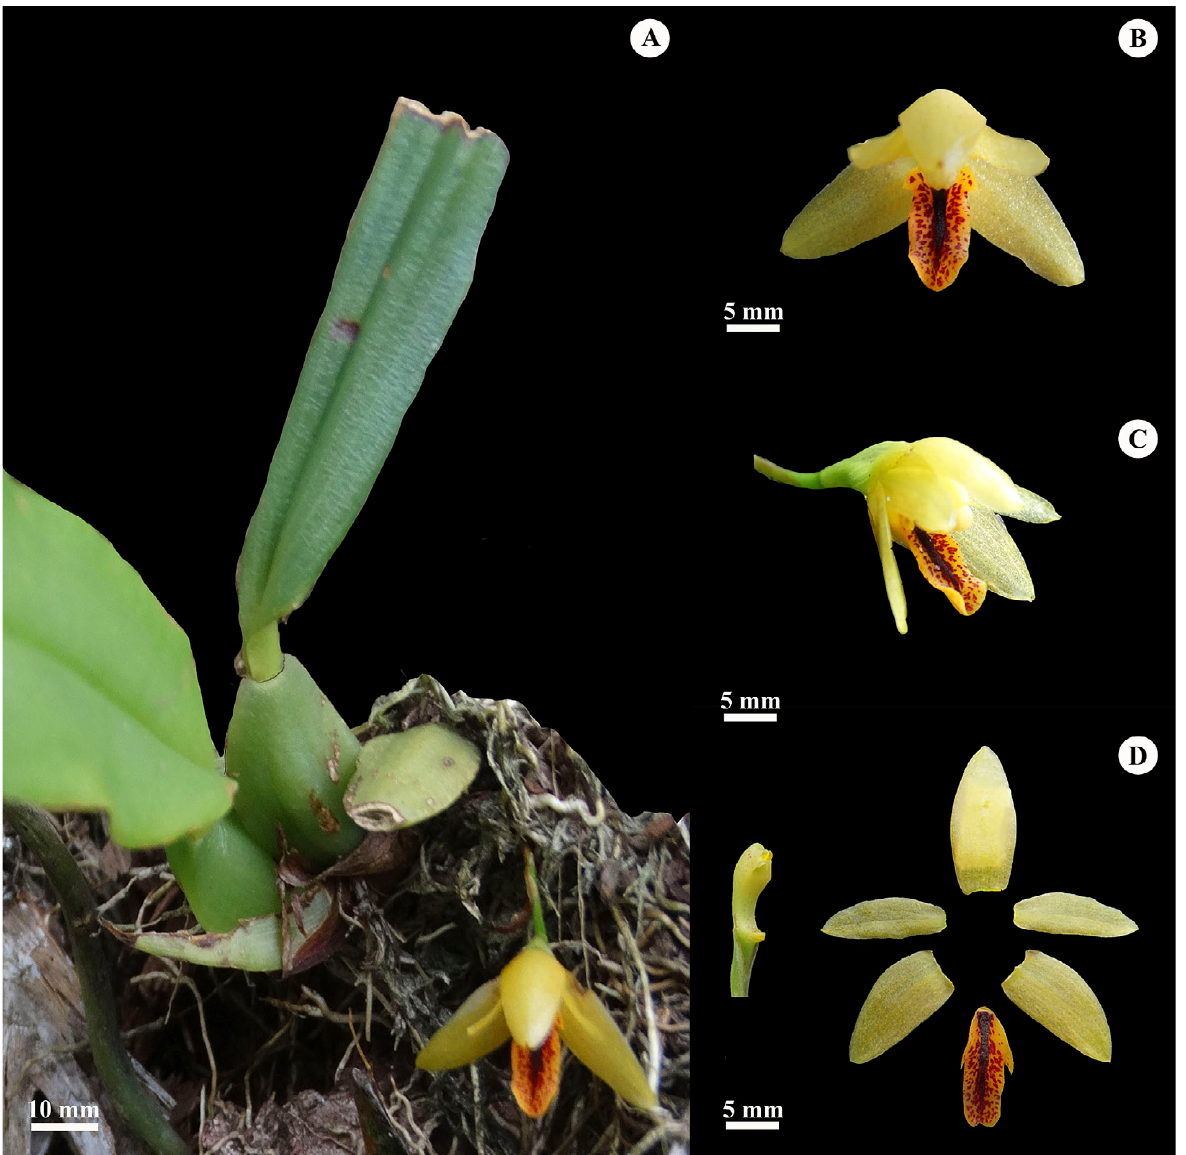
Figure 2. Maxillaria aureoglobula Christenson (MAR 11538). A. Flower in frontal view. B. Flower in lateral view. C. Dissected perianth. D. Habit. (Photographs by